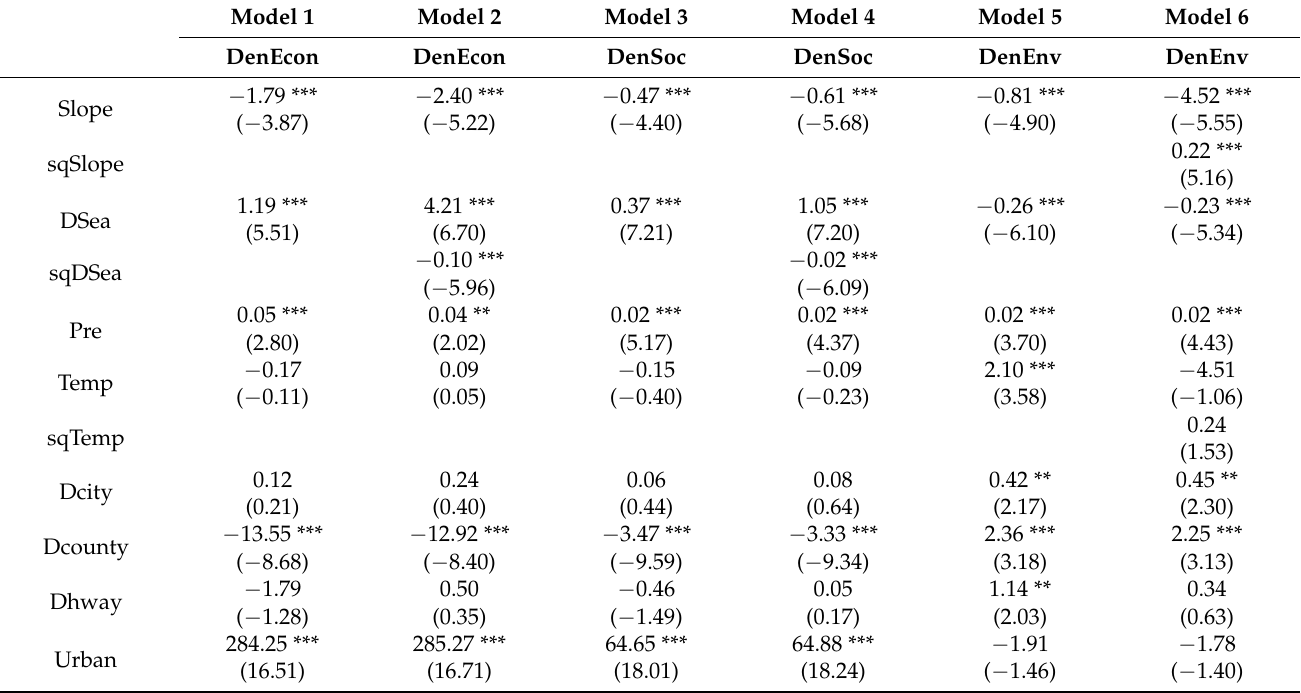
Table 5. Regression results of the econometric